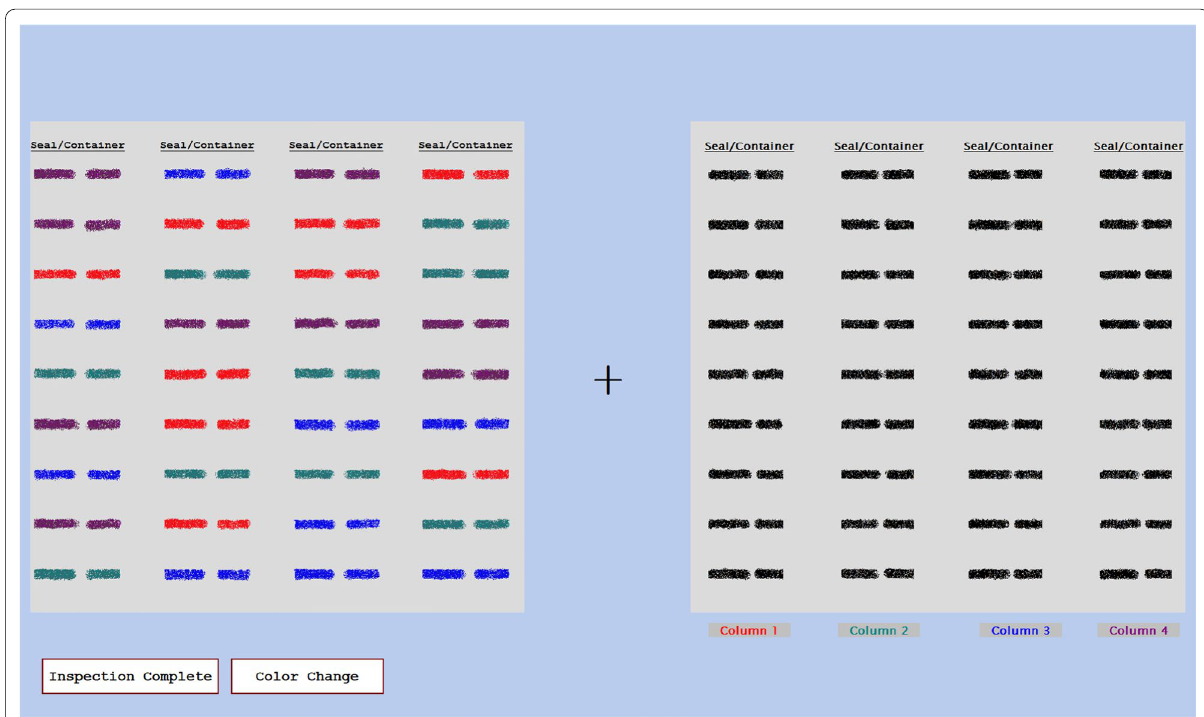
Fig. 2 An example of a participant’s color-coded list from the artificial foveation